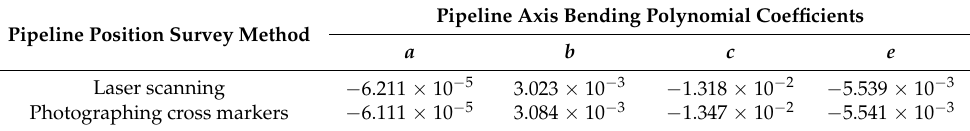
Table 1. Polynomial coefficients for the curved axis of the pipeline in the case of its laser scanning and photographing of markers.